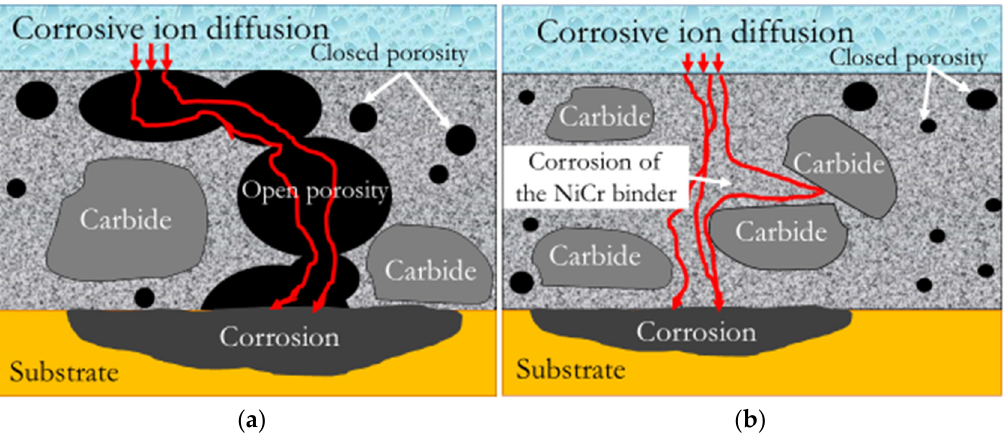
Figure 1. Initiation and growth of corrosion in a typical Cr 3 C 2 ‐ NiCr coating through ( a ) interconnected porosity, and ( b ) metallic binder.